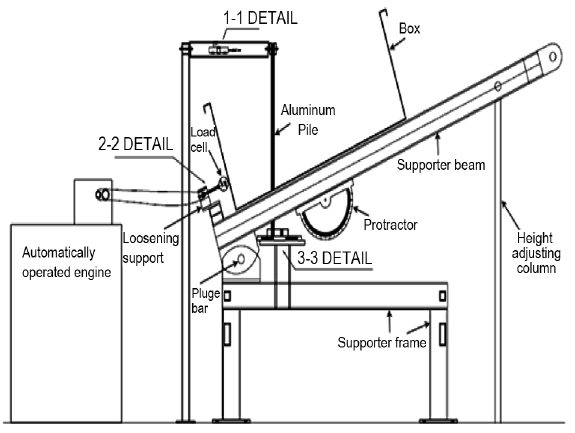
Fig. 1. Section view of experimental setup (Kahyaoğlu 2010)